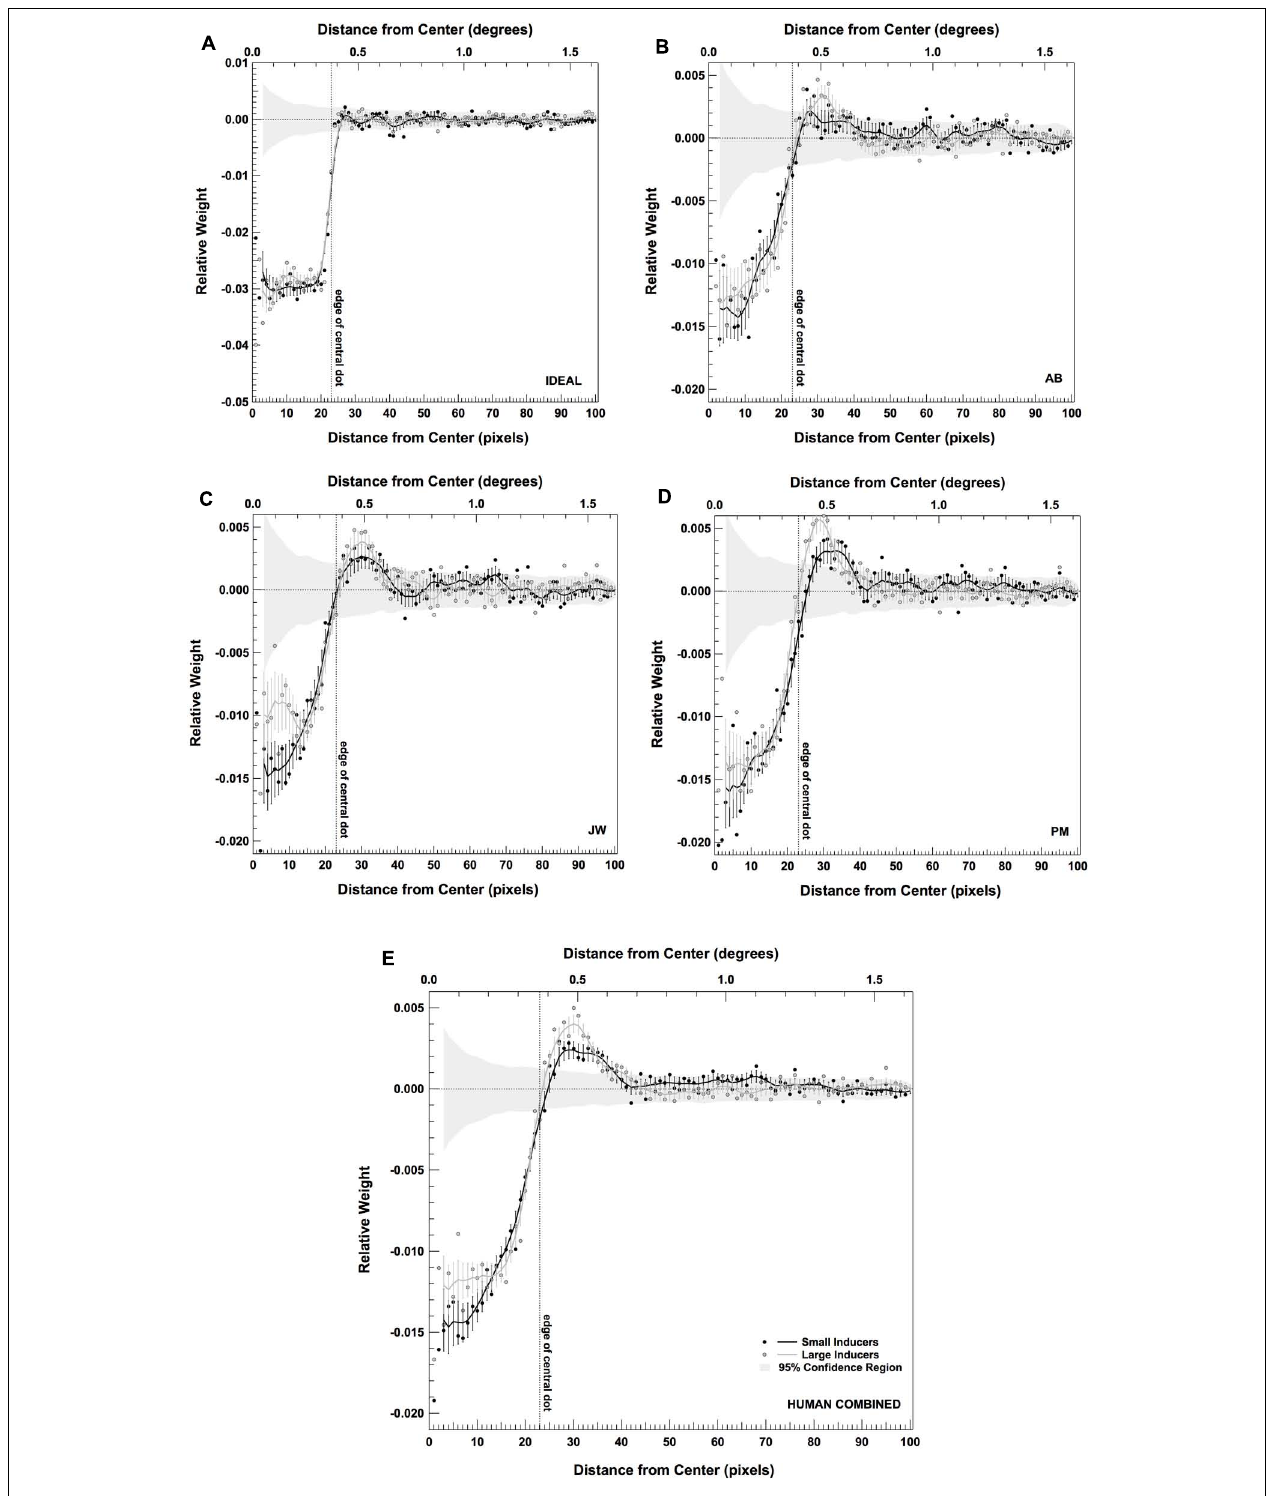
FIGURE 5 | Radially averaged classification images for the ideal observer (A), three human observers (B–D) and the combined data across all three human observers (E) in each condition of Experiment 2. Error bars correspond to ± 2 standard deviations,